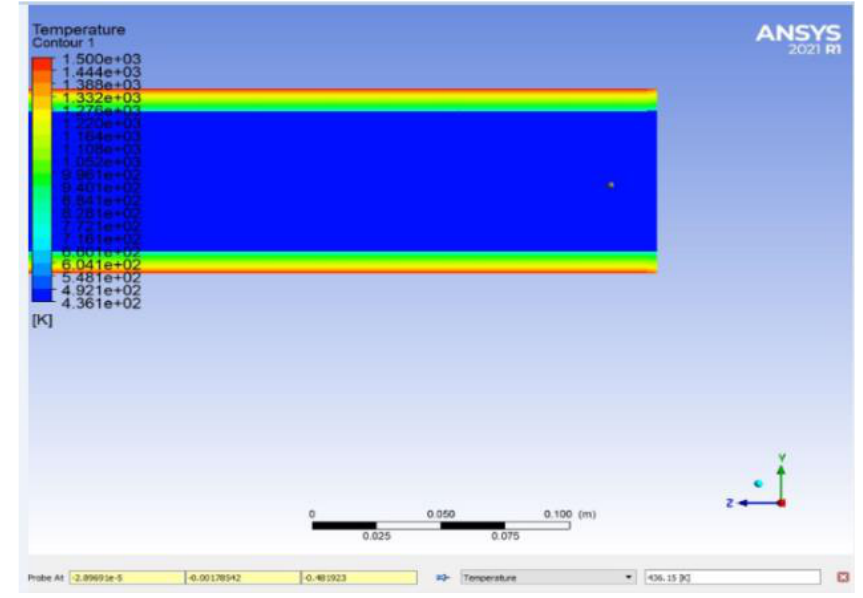
Figure 20. Flue gas temperature distribution on